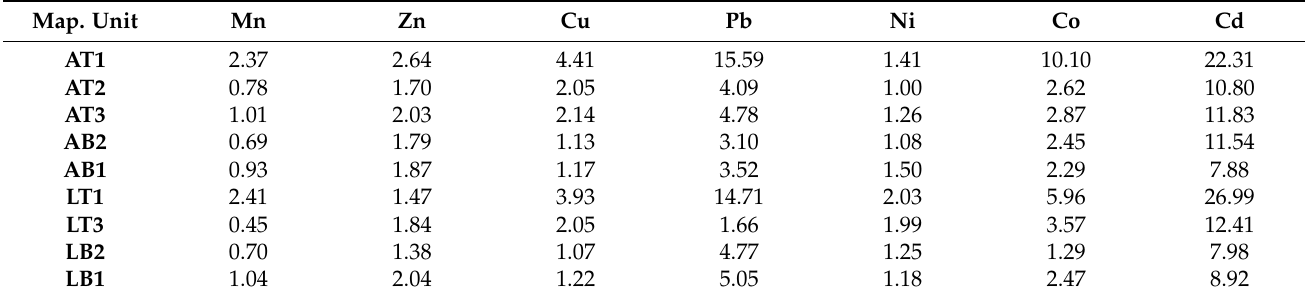
Table 6. Enrichment factor (EF) values of the investigated heavy metals. Map. Unit